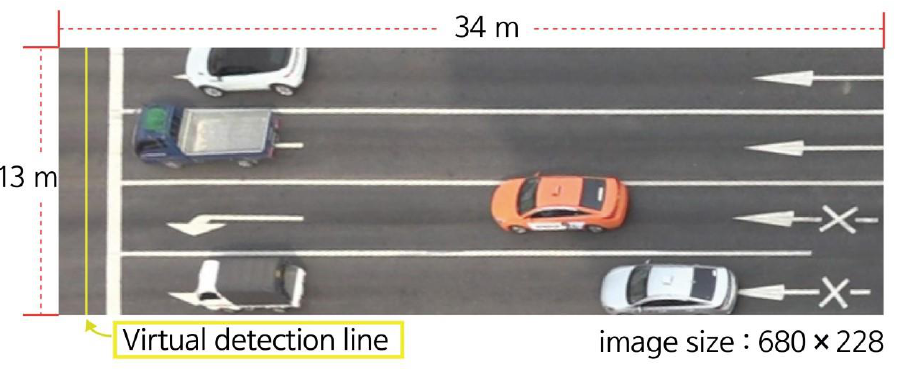
Figure 2. Testbed for the present study.